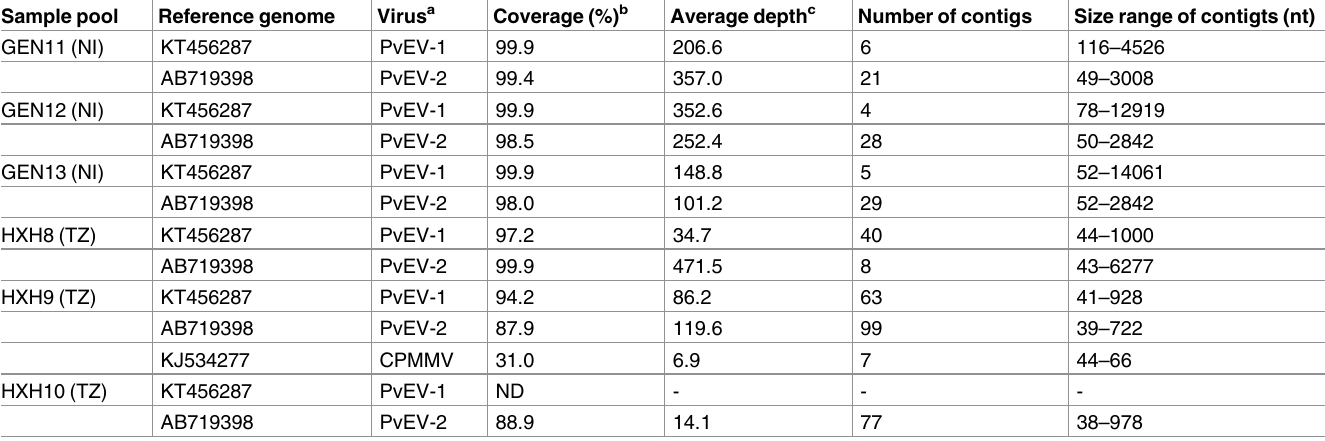
Table 1. Viruses detected in the pools of common bean samples from Nicaragua (NI) and Tanzania (TZ) by VirusDetect. Sample